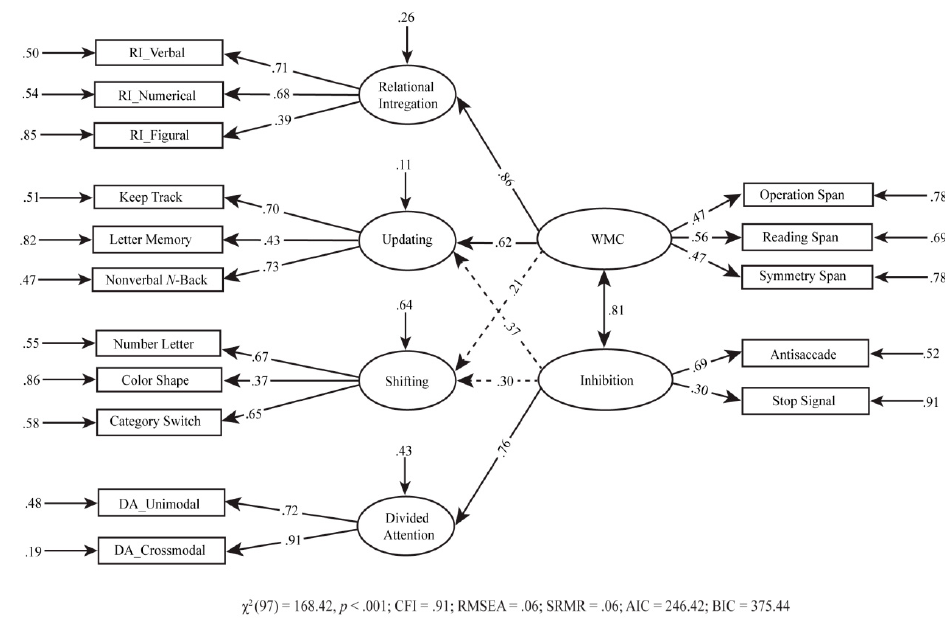
Figure 3. Two-layer six-factor model. The proportion of residual variance of each indicator was calculated by subtracting the variance of the indicator from 1. Not significant ( p < .05) paths are indicated as the dotted line. WMC = working memory capacity; RI = relational integration; DA = divided attention. Table 3. Fit statistics of executive functioning (EF)